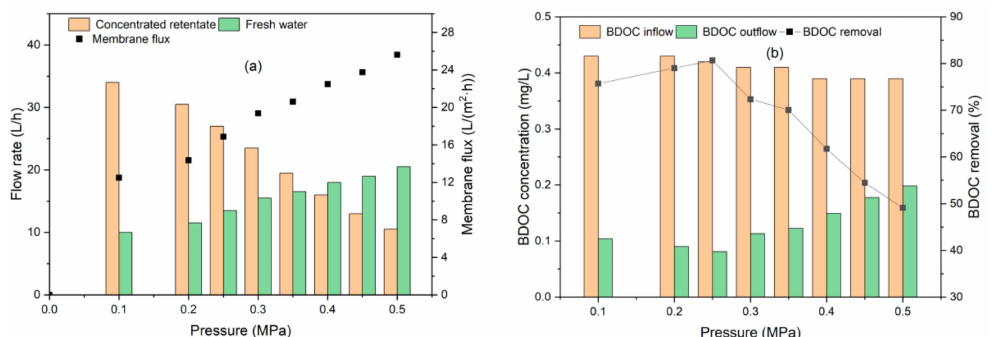
Figure 5. Effect of UF operating pressure. ( a ) Membrane flux; ( b ) removal of